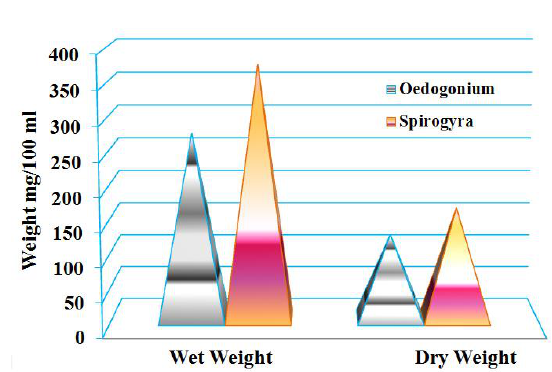
Figure 5. The wet weight and dry weight of Spirogyra and Oedogonium sp.